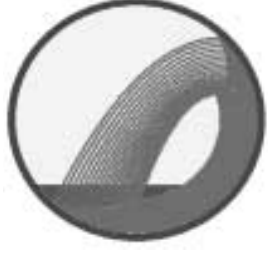
Simulation of Charge Motion